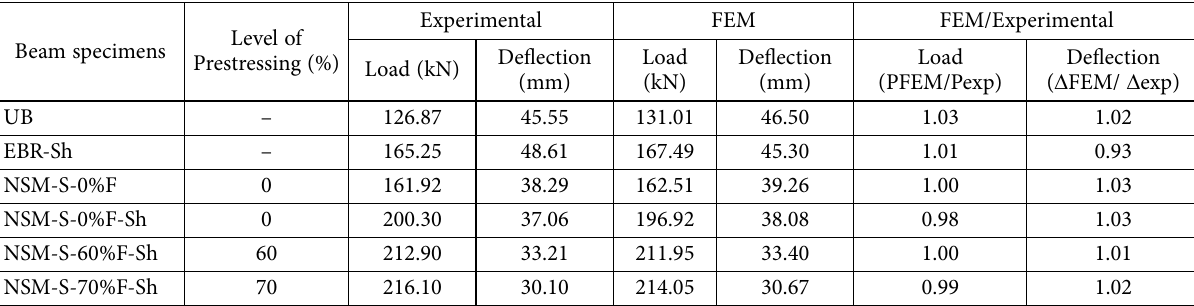
Table 4. Comparison between experimental and FEM output at Ultimate